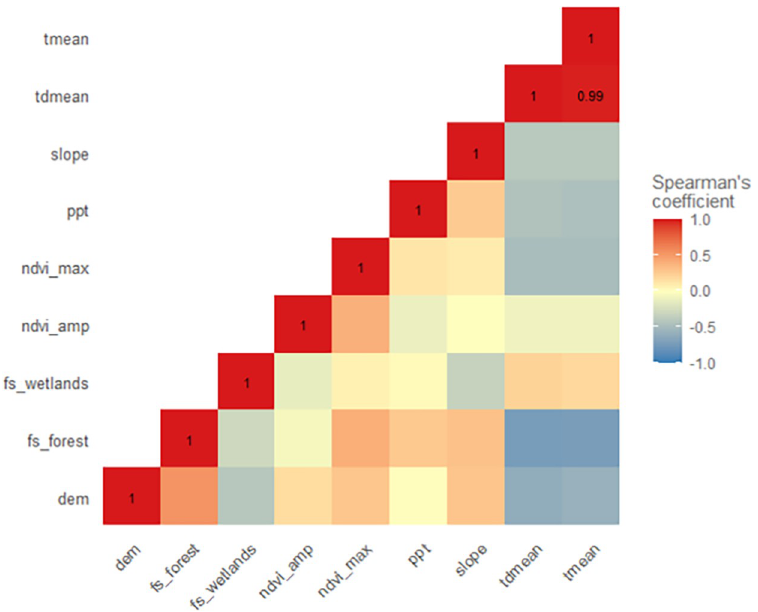
Fig 5. Maximum entropy variable correlation matrix. tmean—mean temperature, tdmean—mean dewpoint temperature, slope—degree of slope, ppt—precipitation, ndvi_max—NDVI maximum, ndvi_amp—NDVI amplitude, fs_wetlands—wetlands focal statistics, fs_forest—forest focal statistics, dem—digital elevation model.